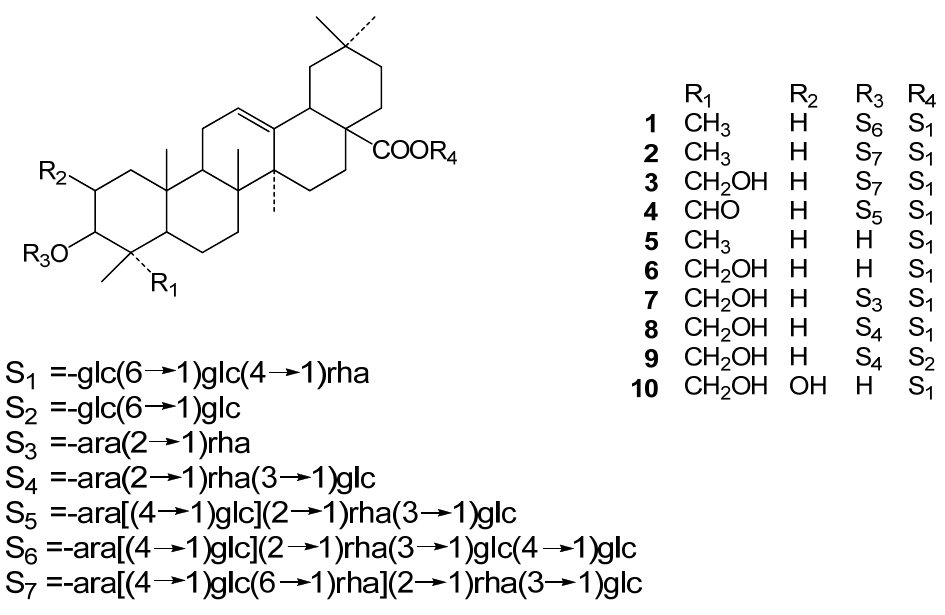
Figure 1. Chemical structures of compounds 1–10